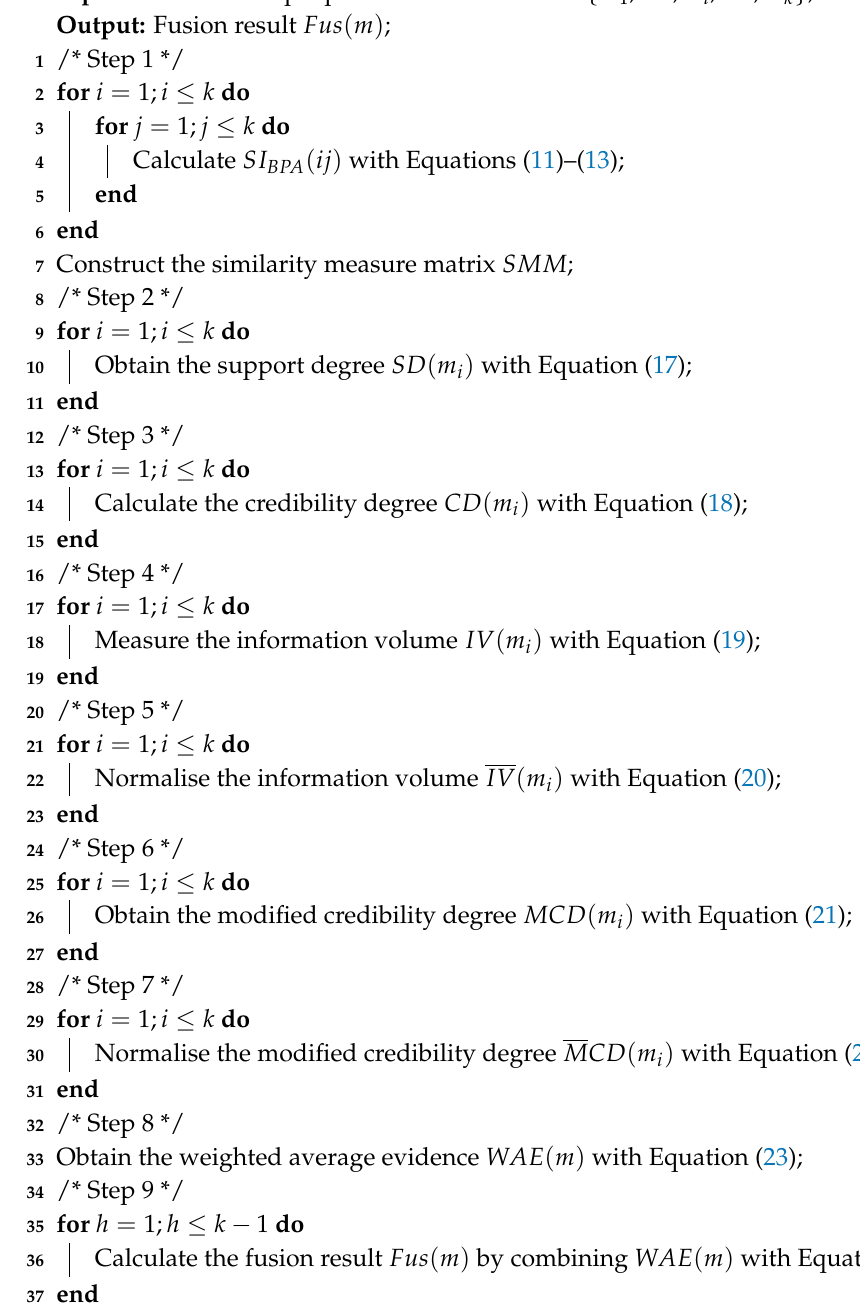
Algorithm 1: A weighted fusion method for multiple pieces of